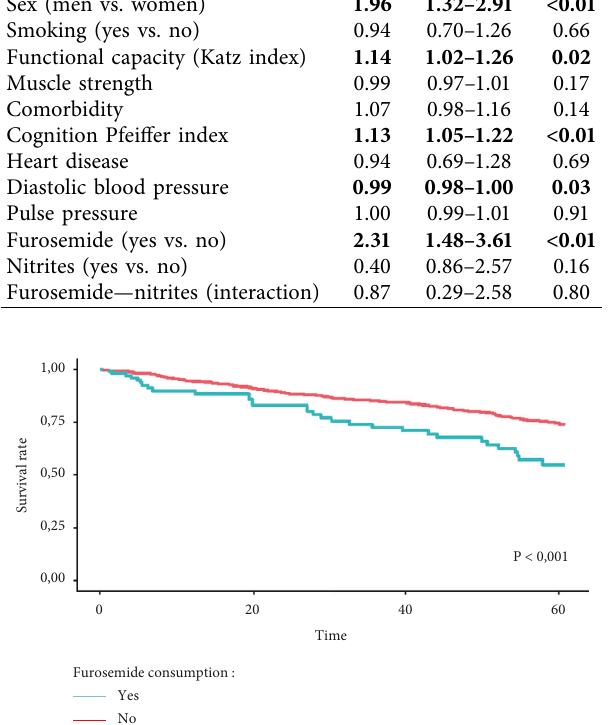
Figure 2: Survival in elderly persons exposed and not exposed to furosemide (adjusted for other risk factors of death: age, sex, smoking, functional capacity, muscle strength, comorbidity, cog- nition, heart disease, diastolic blood pressure, pulse